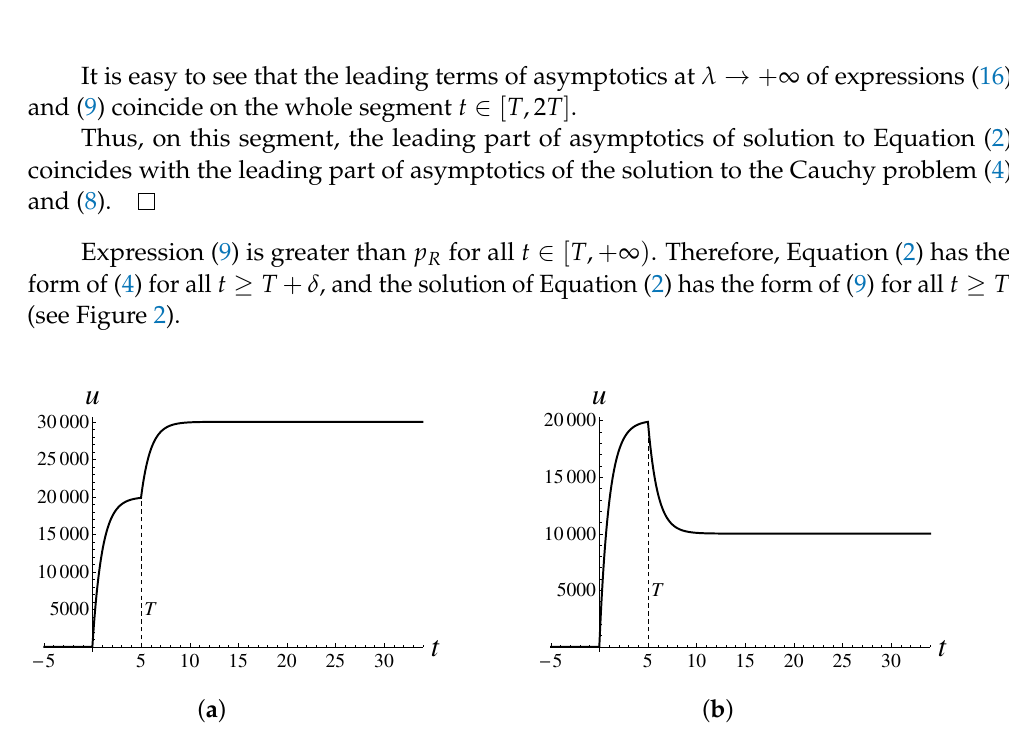
Figure 2. Typical graphs of solutions to Equation (2) with initial conditions from S − in the case b > 0 and d > 0 if ( a ) d > b > 0 and ( b ) b > d > 0. Values of parameters: λ = 10 4 , T = 5, p L = − 1, p R = 2, b = 2, ( a ) d = 3, and ( b ) d =